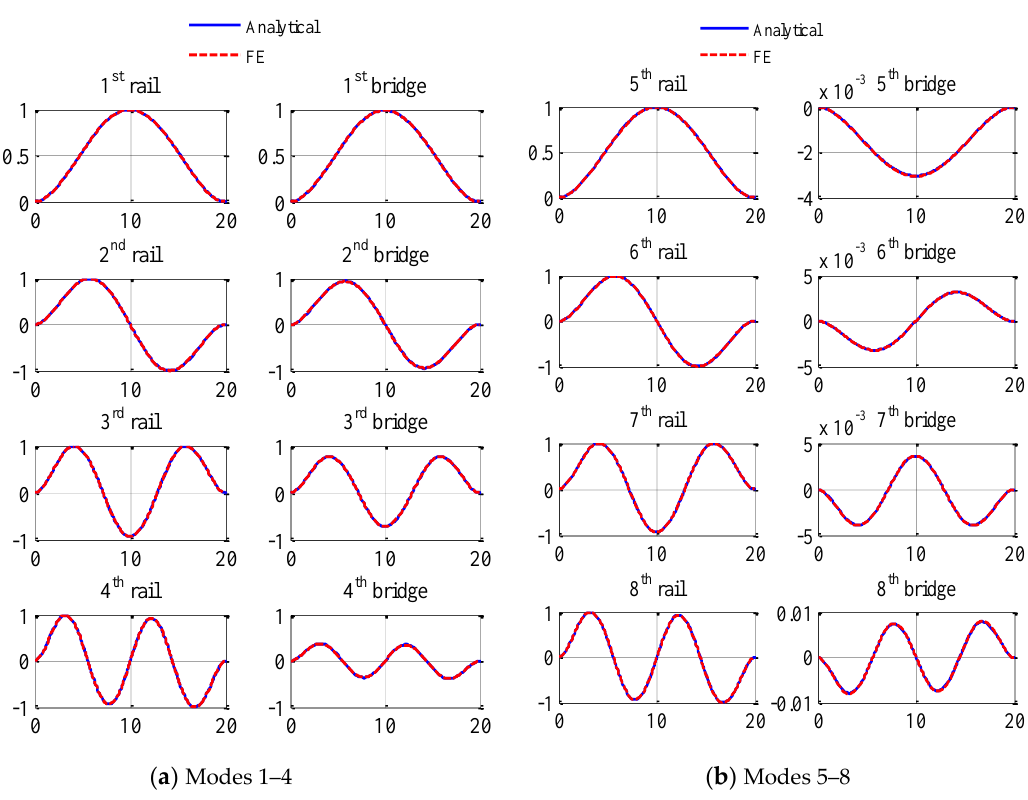
Table 4. Modal frequencies for the fixed-fixed double-beam system. Mode Number